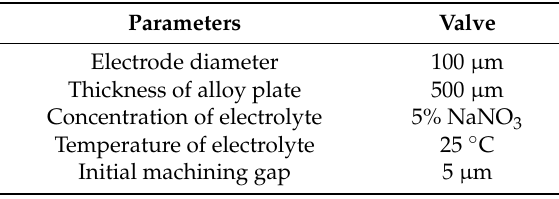
Table 1. Common parameters applied in the